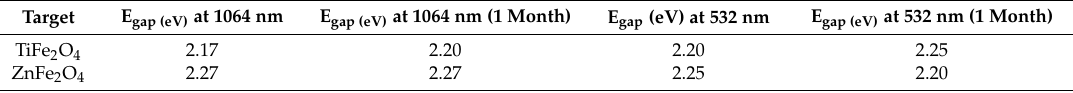
Figure 3. Optical band gap estimation of TiFe 2 O 4 and ZnFe 2 O 4 NPs produced with laser ablation technique in water at 1064 and 532 nm wavelengths ( a ) the day of growth ( b ) one month after the synthesis. Table 2. Optical band gap of MONPs produced with laser ablation technique in water at 1064 and 532 nm wavelengths.